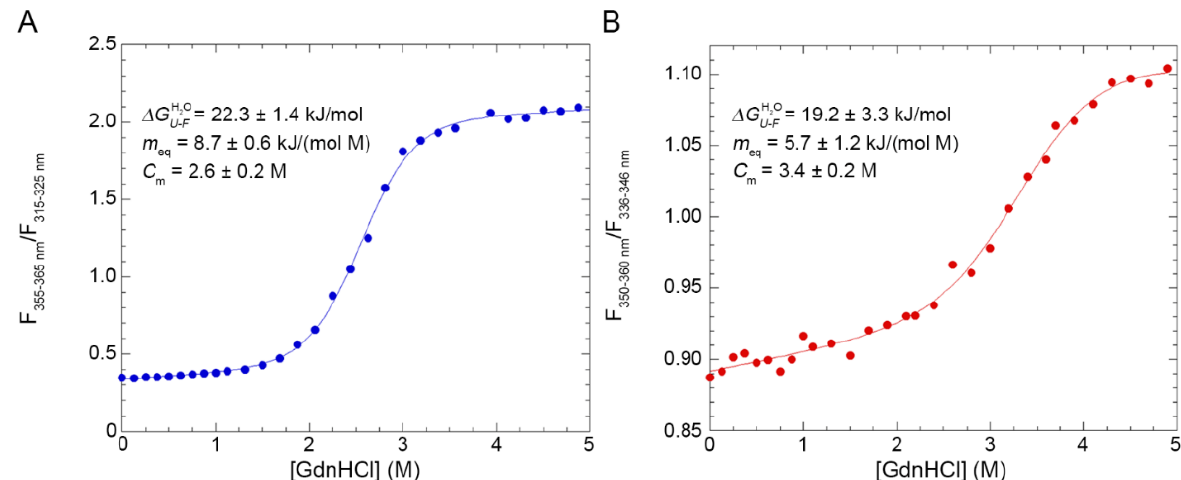
Figure 4. GdnHCl-induced denaturation curves of TDP-43 NTD. The curves refer to TDP-43 NTD in Figure 4 . GdnHCl-induced denaturation curves of TDP-43 NTD . The curves refer to TDP-43 NTD 0.0% ( A ) and 3.0% ( B ) SB3-10. All SB3-10 percentages are w / v . The ratio between the in 0.0% ( A ) and 3.0% ( B ) SB3-10. All SB3-10 percentages are w/v . The ratio between the fluorescence values observed at the indicated wavelength windows, in which fluorescence emission was marked at high and low GdnHCl concentrations, respectively, was obtained at each GdnHCl concentration and plotted as a function of the GdnHCl concentration. Data were analysed with a best-fitting pro- cedure using the two-state model equation [31]. The writings inside the panels indicate the values obtained for the analysed parameters.